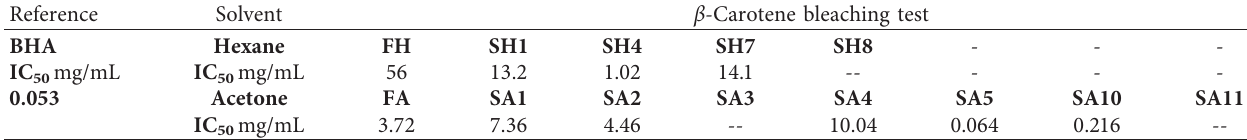
Table 7: Antioxidant activity, β -carotene bleaching test of mother extracts of hexane and acetone, and their fractions. Reference Solvent β -Carotene bleaching test